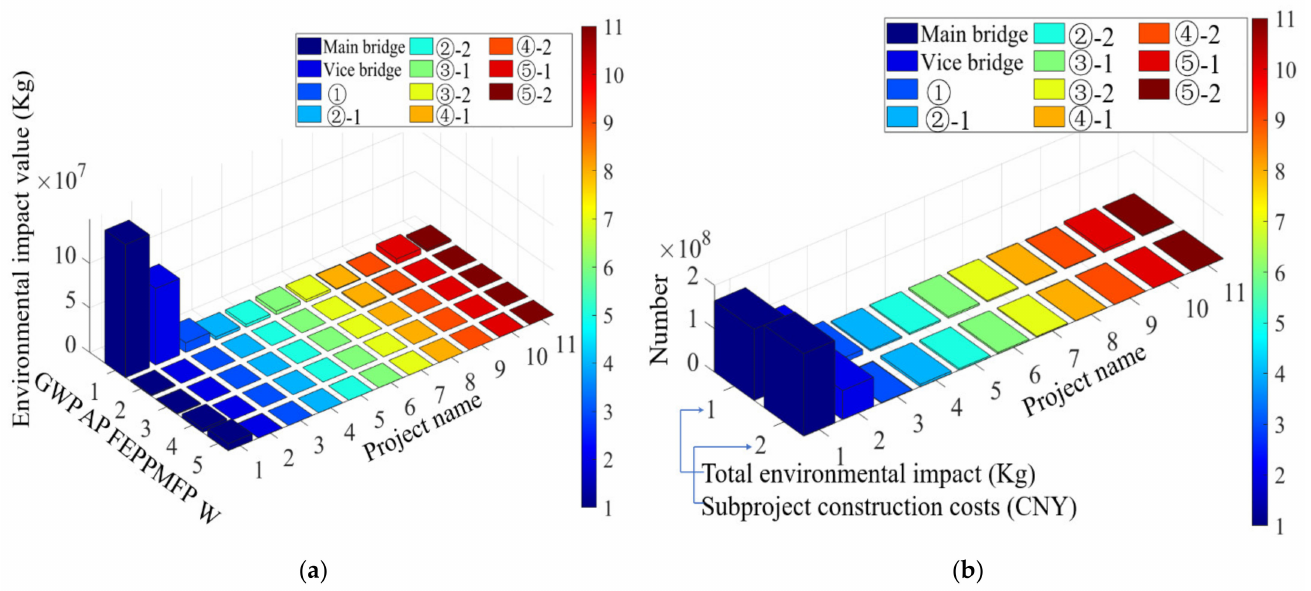
Figure 10. Subproject analysis: ( a ) The environmental impact of the subprojects; ( b ) The economic cost values of the